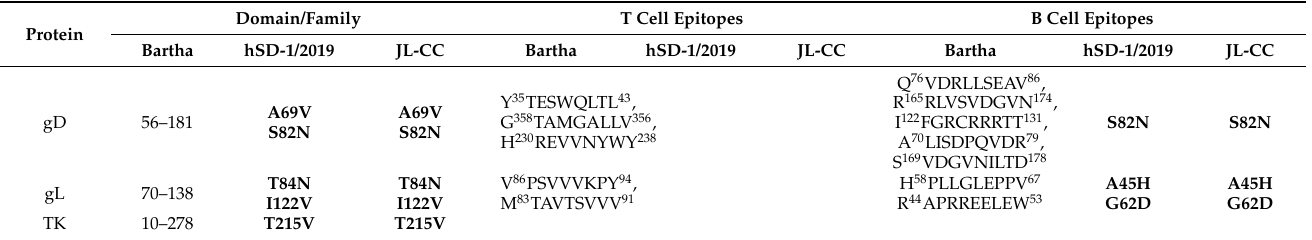
Table 1. Mutations in gD, gL, and TK proteins of PRV hSD-1 2019 and JL-CC strains compared with that of the Bartha strain.